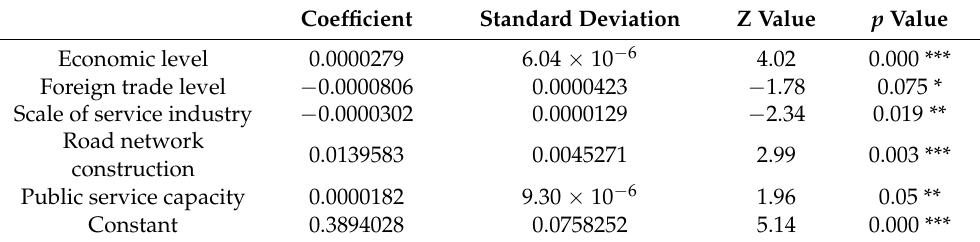
Table 7. The results of factors influencing logistics efficiency of China’s coastal